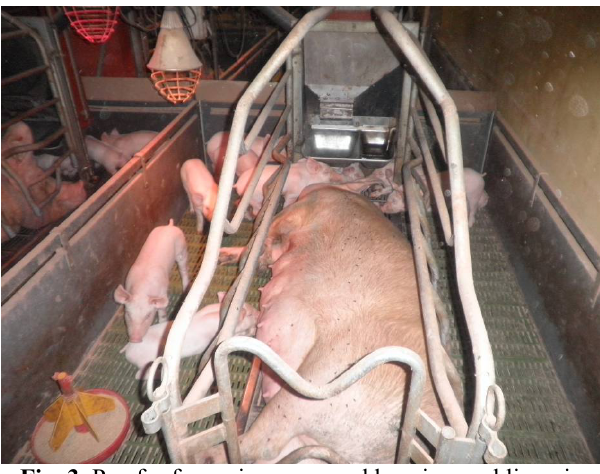
Fig. 3. Pen for farrowing sows and keeping suckling pigs with additional feeding in the feeder (I-TEK